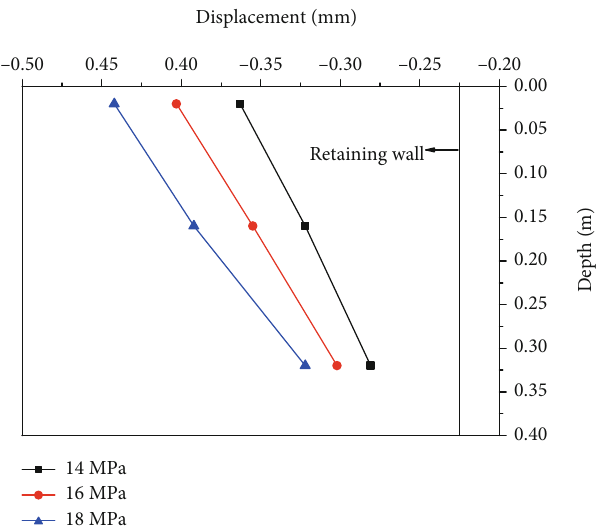
Figure 9: Displacement changes of retaining wall under di ff erent